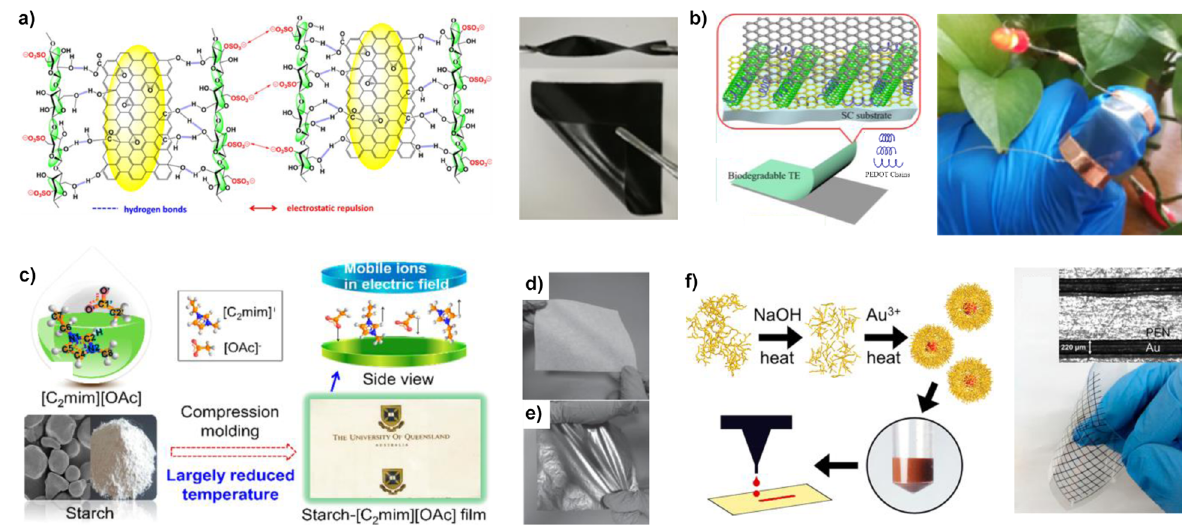
Fig. 2 Conductive fi lms derived from starch. a Mechanism of the starch-aiding dispersion of graphene and a photograph of the corresponding conductive fi lm. Reproduced with permission 65 . Copyright 2017, American Chemical Society. b Structural illustration and photograph of fl exible conductive fi lm with CNT – PG – PEDOT on starch and chitosan composite. Reproduced with permission 38 . Copyright 2018, American Chemical Society. c Starch-based conductive fi lms prepared with ionic liquid as plasticizer. Reproduced with permission 59 . Copyright 2017, American Chemical Society. d Photograph of the porous cellulose fi ber substrate and e the paper-like conductor after impregnating with inks of Mater-Bi starch-based polymer and graphene. Reproduced with permission 70 . Copyright 2015, Wiley. f Preparation process and image of the conductive fi lm with inkjet printing of AuNP ink using starch as reduce agent. Reproduced with permission 71 . Copyright 2018, American Chemical